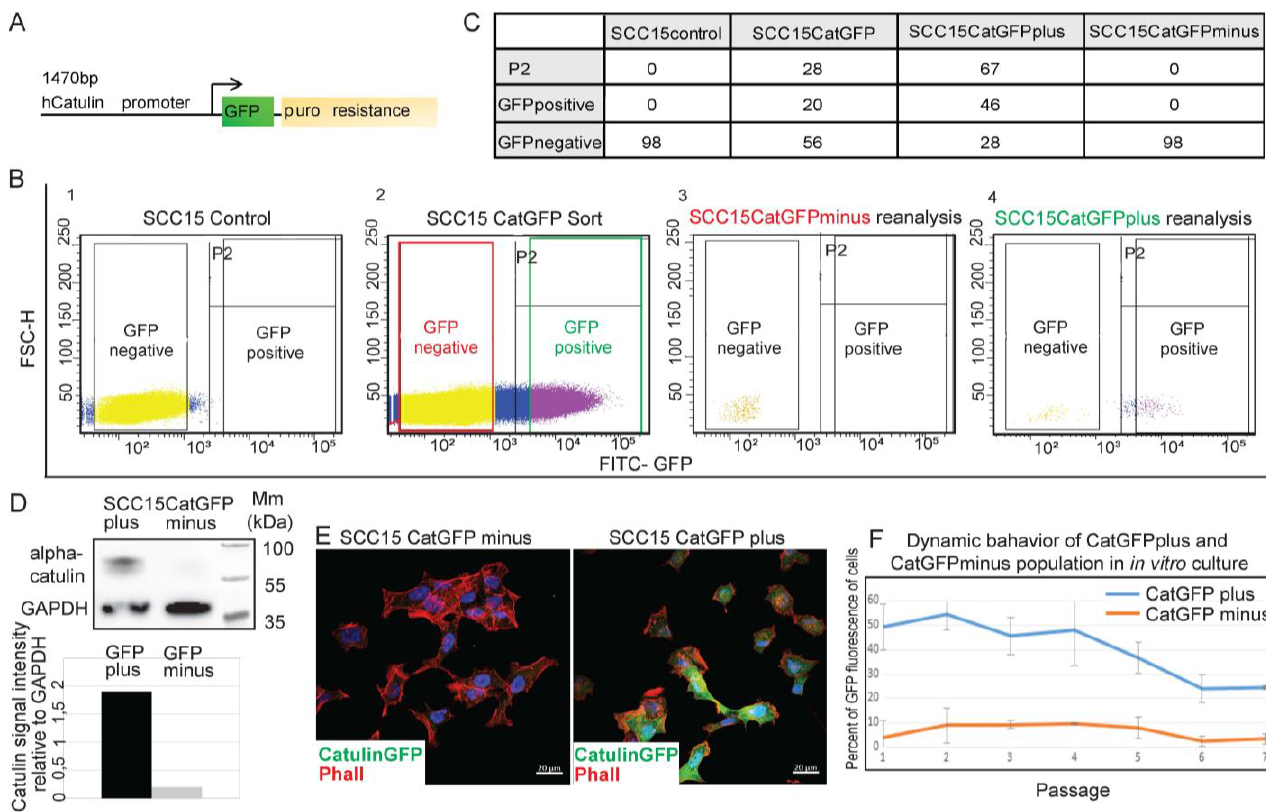
Figure 1. Catulin-promoter-based reporter system to label and track the population of invasive cancer cells of head and neck squamous cell carcinoma (HNSCC). ( A ) Schematic visualization of the reporter system. To generate the alpha-catulin reporter system, a human alpha-catulin promoter clone (containing a 1.5 kb insert corresponding to the 5’-flanking sequence from approximately 1400 upstream to 41 downstream of the human alpha-catulin gene transcription start site (TSS)) was placed upstream of a green fluorescent protein (GFP) in a 4400 bp vector with puromycin as a stable selection marker. The nucleotide identity and direction of the insert were verified by sequencing of both strands. ( B ) Fluorescence-activated cell sorting (FACS) analysis result of SCC15CatGFP cells in vitro. The fluorescence analysis results of the control SCC15 cells ( 1 ) and the sort of the reporter cell line SCC15CatGFP ( 2 ) are shown. SCC15CatGFP was sorted into two populations, i.e., GFP minus (cells with no expression of alpha-catulin, with no fluorescence of GFP) and GFP plus (cells with the expression of alpha-catulin and with fluorescence of GFP). P2 gate contained all the cells that had GFP fluorescence; however, the gate for sorting was set more restrictively, and only cells from the GFP-positive gate were sorted (green frame). The reanalysis of the sorted SCC15CatGFP reporter cell line (SCC15CatGFP minus ( 3 ) and SCC15CatGFP plus ( 4 ) populations) are shown. ( C ) Percentage quantification of each cell type (GFP-positive and GFP-negative) in each cell line (SCC15 Control, SCC15CatGFP, SCC15CatGFP plus, and SCC15CatGFP minus). ( D ) Western blot analysis of alpha-catulin protein levels in the sorted SCC15CatGFP plus and SCC15CatGFP minus cells. GAPDH protein was used as a loading control. The graph showed the catulin signal intensity calculated relative to that of GAPDH in ImageJ software. ( E ) Immunofluorescence of the sorted SCC15CatGFP plus and SCC15CatGFP minus cells seeded on coverslip glasses. Catulin-GFP immunofluorescence is indicated in green, phalloidin (actin) immunofluorescence is indicated in red, and 4 (cid:48) 6-diamidino-2-phenylindole (DAPI) immunofluorescence is indicated in blue. Scale bar: 20 µ